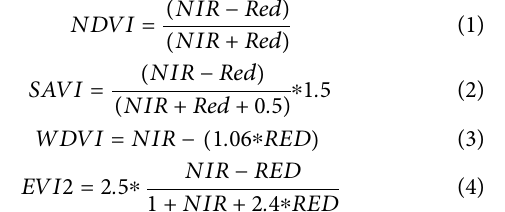
Frontiers in Remote Sensing |